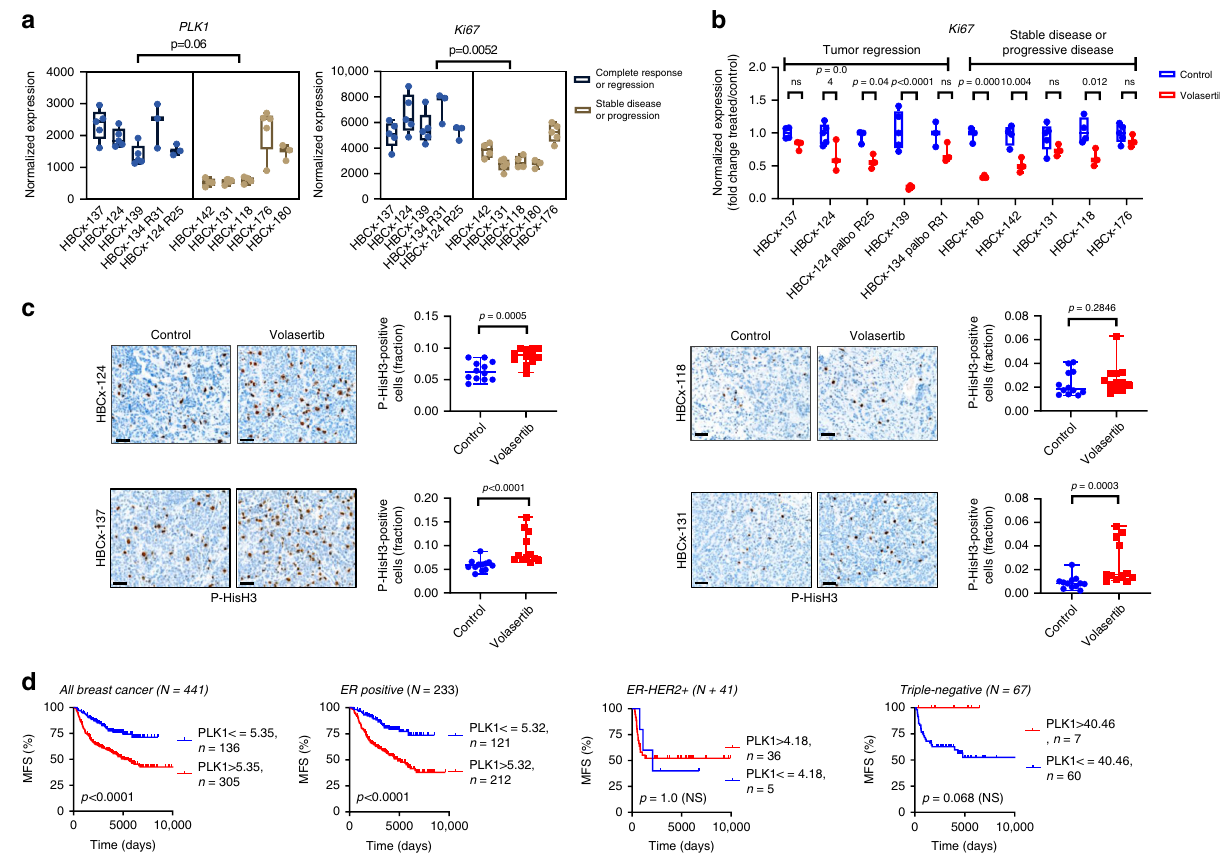
Fig. 5 Analysis of proliferation markers in PDX and prognostic value of PLK1 expression in early ER + BC. a RT-PCR analysis of PLK1 and Ki67 gene expression in control xenografts. Data are presented as a min/max Whiskers plots with line indicating the median. n = 5 for HBCx-137, HBCx-139, HBCx124 and HBCx-131. n = 4 for HBCx-118 and HBCx-142. n = 3 for HBCx-134 palbo-R. (Nested t test, two-sided) b Ki67 gene expression in control and treated PDX samples (fold changes treated/control). Data are presented as a Min/Max Whiskers plots with lines indicating the median. n = 3 for all volasertib-treated xenografts and control xenografts from HBCx-124 palboR25, HBCx-134 palboR31 and HBCx-180; n = 4 control HBCx-137 and HBCx-118 xenografts, n = 5 for control xenografts of the other PDX. (Sidak ’ s multiple comparisons test) c Analysis of phospho-histone H3 (Ser10) expression by immunohistochemistry in control and volasertib- treated xenografts (harvested 24h after a single treatment). Scale bar 50 μ M. Representative picture of n = 3 xenografts/group. For each tumour four tissue sections were analysed. Scatter plots (median with range). (Mann – Whitney t test, two-sided) d Metastasis-free survival (MFS) curves of patient groups from the series of 441 breast tumours according to PLK1 mRNA expression level measured by RT-PCR analysis. The log-rank test was used to identify relations between MFS (metastasis-free survival) and PLK1 mRNA expression. Area under the curve analyses was performed to identify a cut-point to divide the cohort into two relevant PLK1 expression subgroups (low and high PLK1 expression) in the global population and in the different breast cancer sub-groups. Statistical signi fi cance was assessed by the log-rank (Mantel – Cox) test. Source data from a – c are provided as a Source Data fi le. PLK1 expression pattern in human breast tumours, we analysed As PLK1 promotes cell proliferation of various cancers 15,16 , we PLK1 mRNA levels in a large series of 441 primary breast tested possible correlation between PLK1 and various genes tumours from patients with known clinical/pathological status involved in cell cycle signalling pathway, i.e., AURKA , MK67 and and long-term outcome (Supplementary Table 2). Results in the NEK2 , quanti fi ed by RT-PCR analysis in the same cohort global population showed that metastasis-free survival (MFS) of (Supplementary Fig. 4). We observed high positive association patients with high PLK1 -expressing tumours (5-year MFS 68.4%; between PLK1 and these three genes ( r = + 0.828, P < 0.0001 for 10-year MFS 58.5%; 15-year MFS 49.8%) was shorter than that of AURKA ; r = + 0.749, P < 0.0001 for MKI67 ; r = + 0.782, P < patients with low PLK1 -expressing tumours (5-year MFS 88.7%; 0.0001 for NEK2; Spearman rank correlation test). 10-year MFS 77.4%; 15-year MFS 74.4%) ( P < 0.0001; Fig. 5c). This prognostic signi fi cance of PLK1 expression status in the global population was restricted to the hormonal receptor (HR)- positive (HR + HER2 + and HR + HER2 − ) sub-group ( P < 0.0001), and was not observed in the triple negative sub-group, as well as in the HR-HER2 + sub-group. The prognostic signi fi cance of parameters identi fi ed in univariate analysis and PLK1 expression status persisted, except for Scarff Bloom Richardson (SBR) histopathological grade and progesterone receptor (PR) status, in the Cox multivariate regression analysis of MFS (Supplemental Table 3). NATURE COMMUNICATIONS| (2020) 11:4053